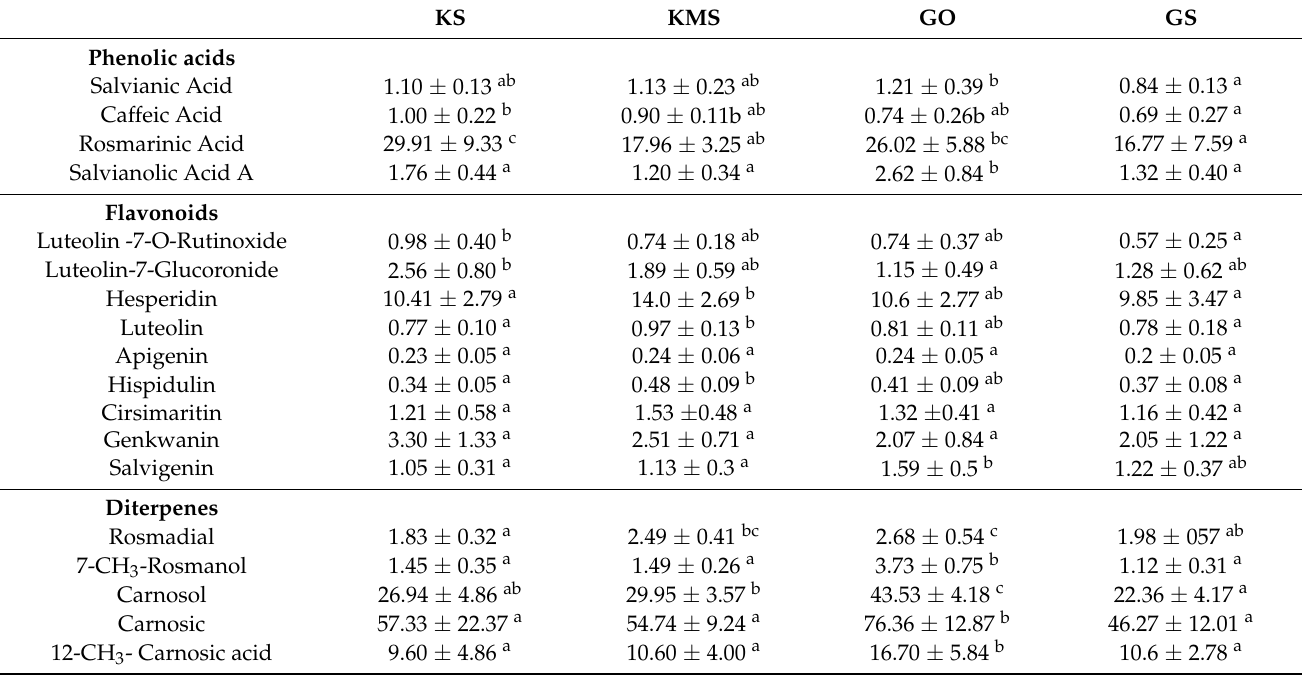
Table 1. HPLC polyphenolic profiles of R. officinalis L. methanolic extracts from the different bioclimatic areas.